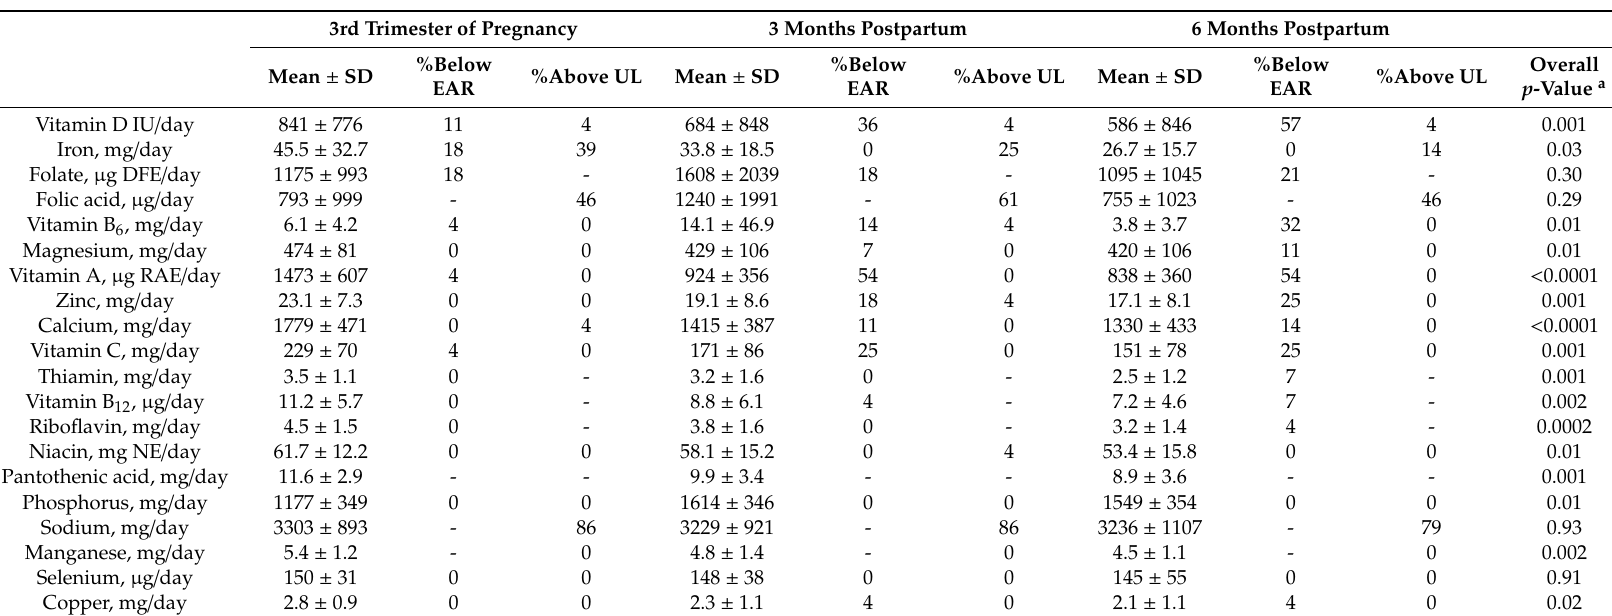
Table 5. Period-specific total micronutrient intake (including food sources and supplements) in comparison with dietary reference